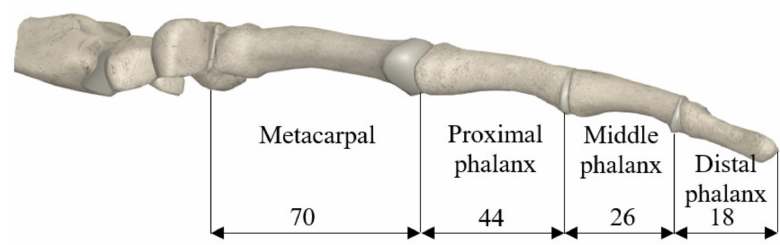
Figure 2. Distances between the interphalangeal joints of the middle finger.